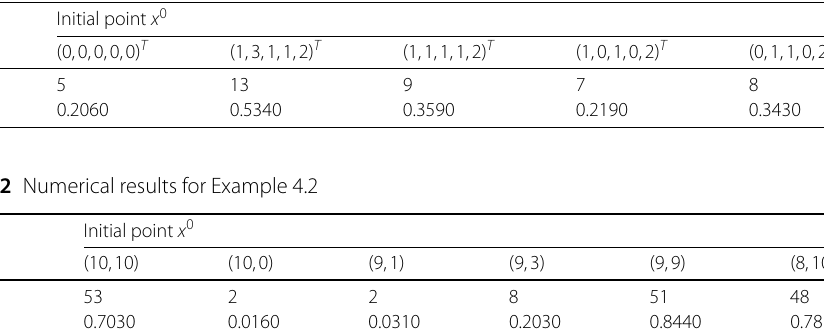
Table 1 Numerical results for Example 4.1